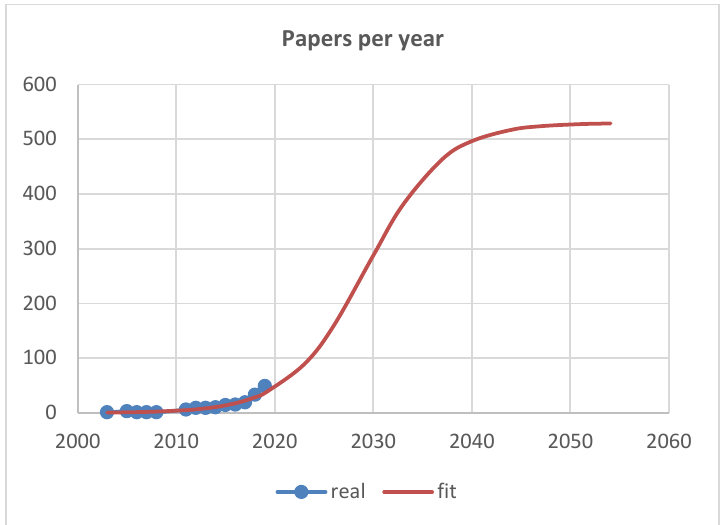
Figure A1. Evolution of scientific production in the field. Saturation circa 2040, with approximately 500 papers per year (r 2 =0.8899).